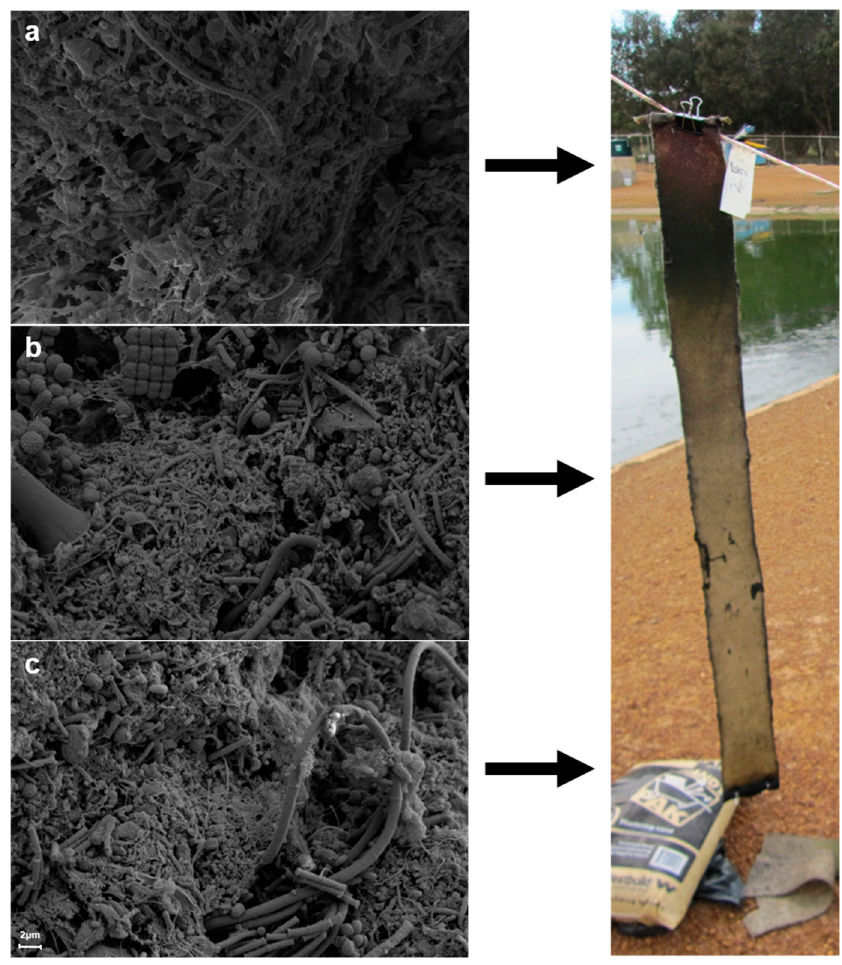
Figure 5. Spatial change in biofilm matrix in the water column (along the baffle test strip) after seven months, shown using scanning electron microscopy (SEM). At the top of the water column ( a ) a thicker biofilm developed that decreased towards the middle ( b ) and bottom ( c ) of the water column.